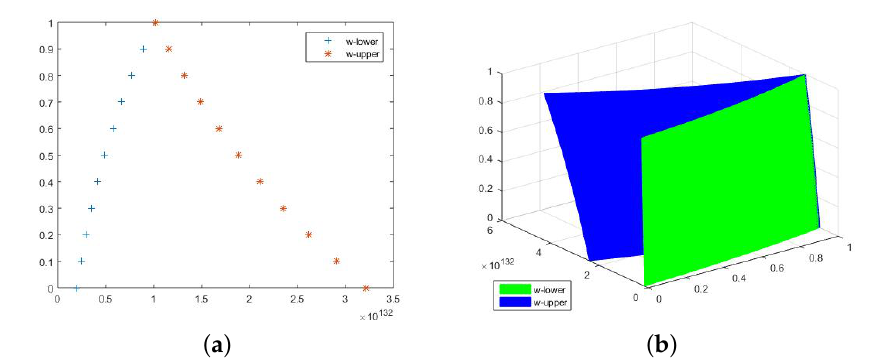
Figure 8. The approximate lower and upper solutions of Equation (156) at Λ = 0.9, ϕ = 0.5, φ = 0.4, t = 7, (cid:61) = 1/2, ı = 4. ( a ) 2 D figure for the approximate solutions of three-dimensional fuzzy fractional diffusion equation of w in Example 10. ( b ) 3 D figure for the approximate solutions of w in Example